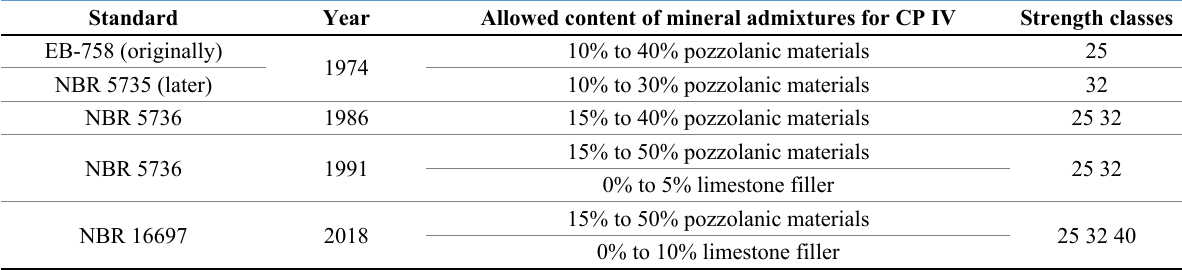
Table 4. Evolution of standardisation of Portland-pozzolan cement (CP IV) in Brazil, in terms of maximum clinker + calcium sulphate replacement in mass.